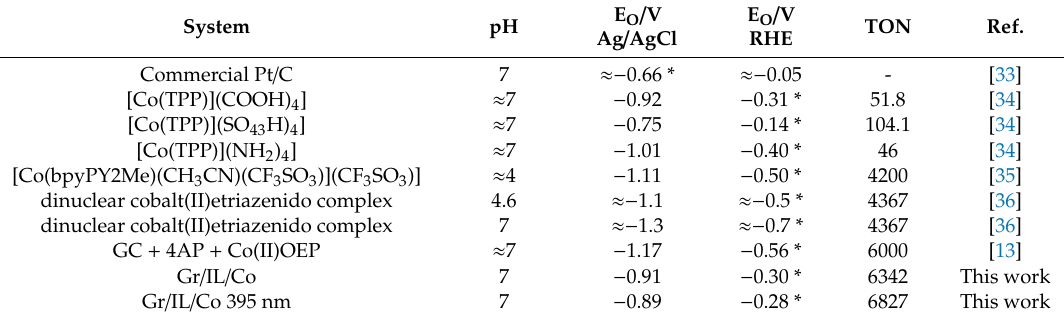
Table 4. Comparison of onset potential (E O ) and catalyst turnover number (TON) in similar systems.